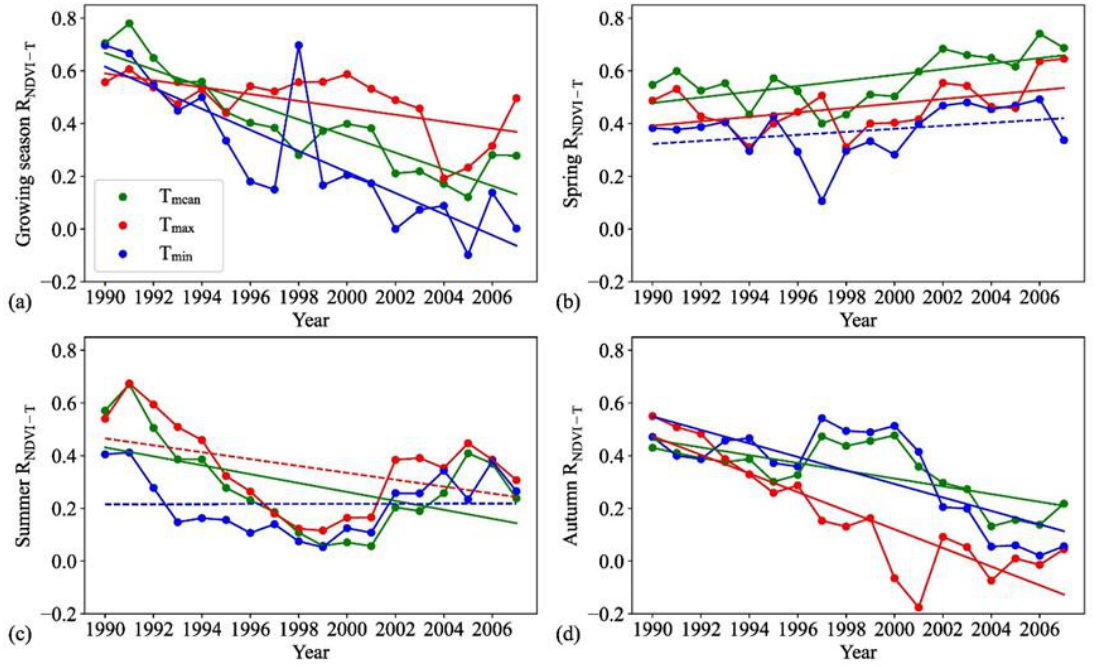
Figure 2. Changes in the partial correlation coefficients between seasonal NDVI and corresponding air temperature (the x axis is the center year of the 17−year moving window, for example, 1990 represents a moving window from 1982–1998, and so on.). Images ( a – d ) are the partial correlation coefficients between NDVI and air temperature during GS ( a ), spring ( b ), summer ( c ) and autumn ( d ), respectively. Solid (dashed) lines represent significant (insignificant) linear regression lines between the partial correlation coefficients and the corresponding center year of the 17−year moving window.